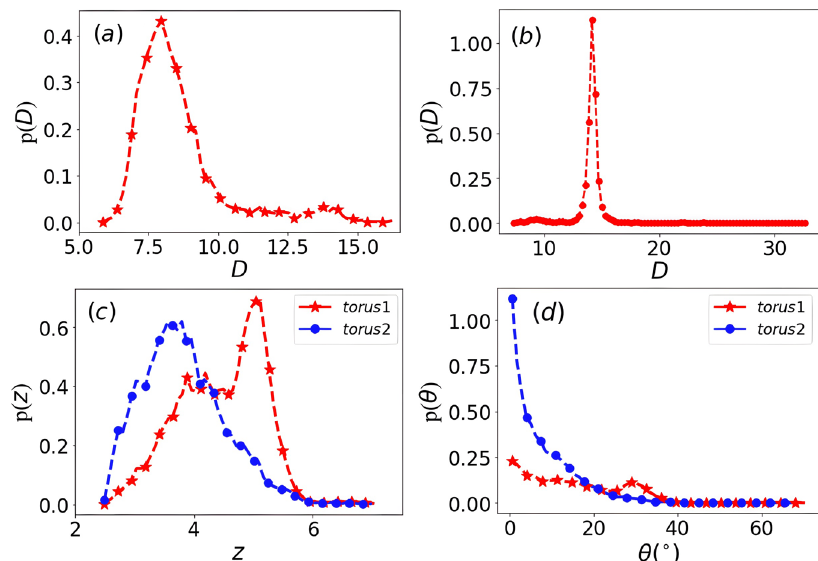
Fig. 5 Probability distributions for two tori near the wall. Probability distributions P ( D ) for forward-moving tori with ϵ c d = 0.2 and g = 0.07 ( a ) and g = 0.09 ( b ). Probability distributions P ( z ) ( c ) and p ( θ ) ( d ) for the parameters ϵ c d = 0.1; and g = 0.07.